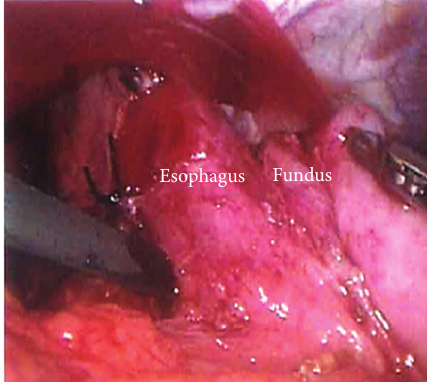
Figure 2: Laparoscopic Nissen fundoplication technique. Creation of the fundoplication “wrap” by passing the fundus of the stomach behind the esophagus (through the retroesophageal window). This is called the “shoe shine maneuver.”